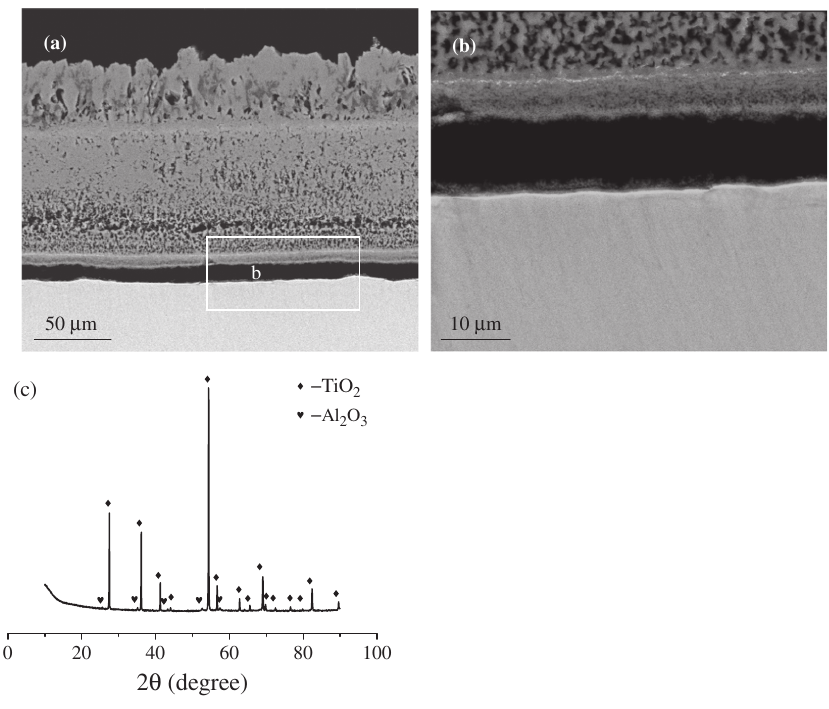
Figure 6: Micrograph (SEM/BEI) of a cross section and XRD spectrum of Ti-5Al-2.5Sn oxidized in air at 850°C for 24 h: (a) general view, (b) enlarged view of the selected area of (a), (c) XRD spectrum.